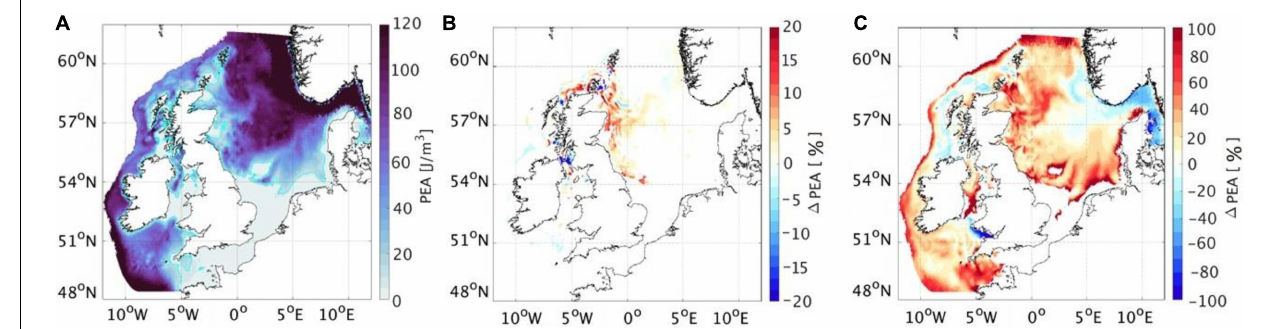
FIGURE 3 | Present June–July–August potential energy anomaly (PEA, defined as an indicator to measure stratification and mixing rate) (A) , future PEA under 6 GW energy extraction (B) and future PEA under “business as usual” (worst case) greenhouse-gas emissions scenario in 2050 (C) . Data provided from the unstructured grid coastal ocean model, FVCOM (Finite-Volume Community Ocean Model, Chen et al., 2003), using an implementation known as the Scottish Shelf Model (SSM, Wolf et al., 2016); for more information, see De Dominicis et al.